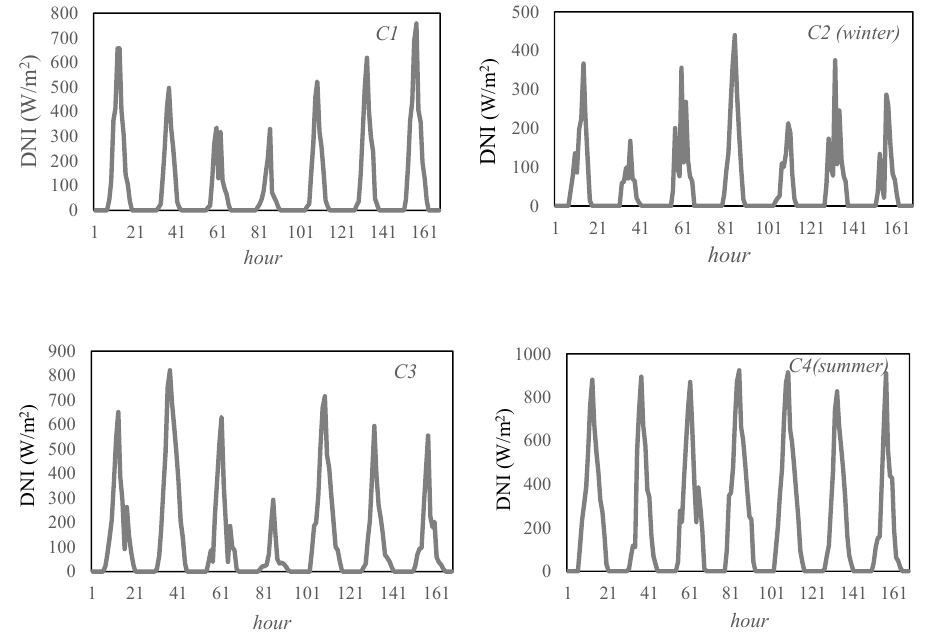
Figure 5. Direct Normal Irradiation (DNI) weekly distribution for the four clusters.